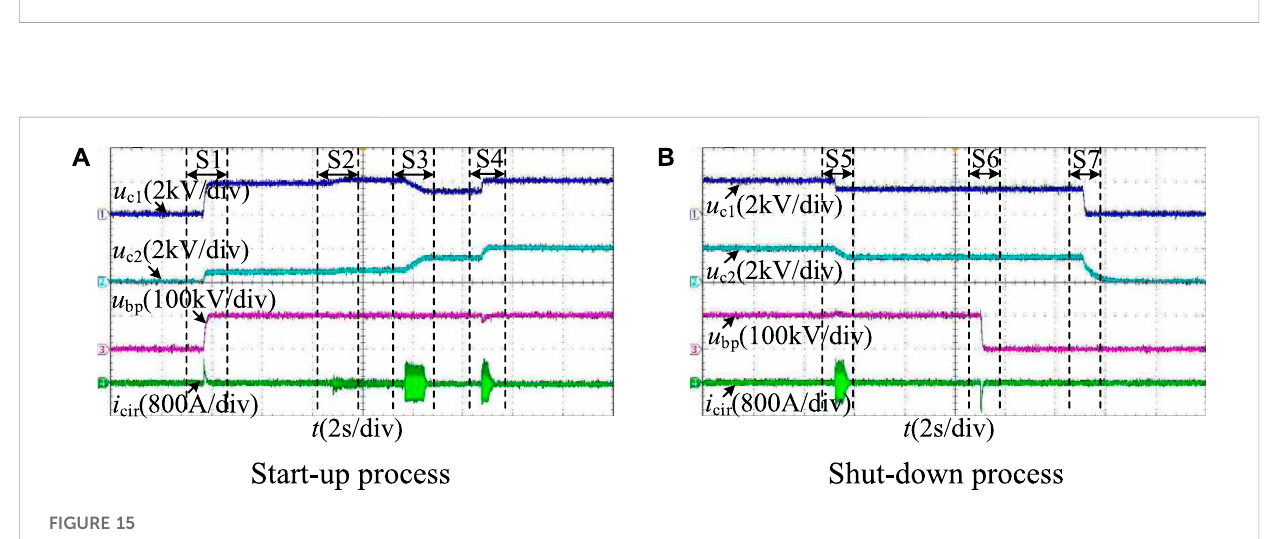
FIGURE 15 Experimental results. (A) Start-up process. (B) Shut-down